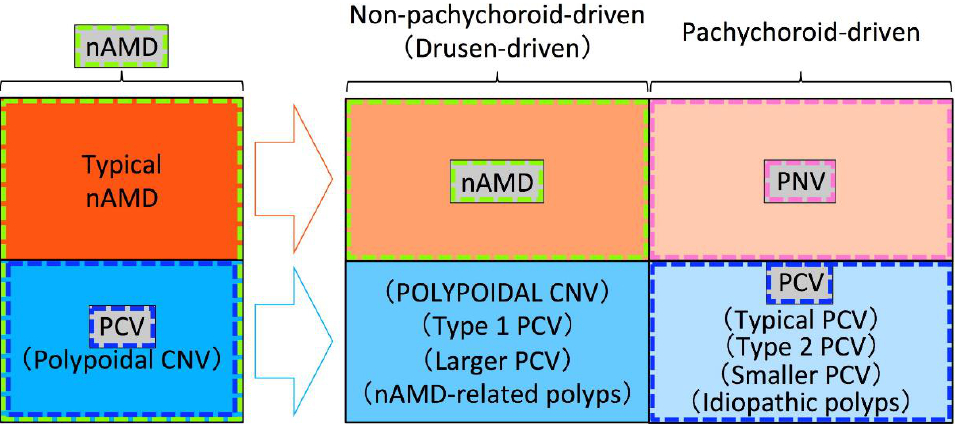
Figure 3. An example of the framework used in previous studies. Among exudative maculopathy previously diagnosed as nAMD, typical nAMD is divided into nAMD that is non-pachychoroid-driven (drusen-driven) and pachychoroid neovasculopathy (PNV) that is pachychoroid-driven, while polypoidal choroidal vasculopathy (PCV) is divided into macular neovascularization (MNV) with polypoidal lesions that is non-pachychoroid-driven (drusen-driven) and PCV that is pachychoroid-driven, in the era of the pachychoroid concept. nAMD includes only non-pachychoroid-driven MNV without polypoidal lesions, PNV includes only pachychoroid-driven MNV without polypoidal lesions, and PCV includes only pachycho- roid-driven MNV with polypoidal lesions. An appropriate term for non-pachychoroid-driven MNV with polypoidal lesions has not yet been proposed. Since the “polypoidal CNV” had been proposed for CNV in PCV or PCV itself and the usage of “POLYPOIDAL CNV” by Yuzawa et al. differs f rom the originally used term “polypoidal CNV”, “POLYPOIDAL CNV” by Yuzawa et al. is written in uppercase for differentiation.